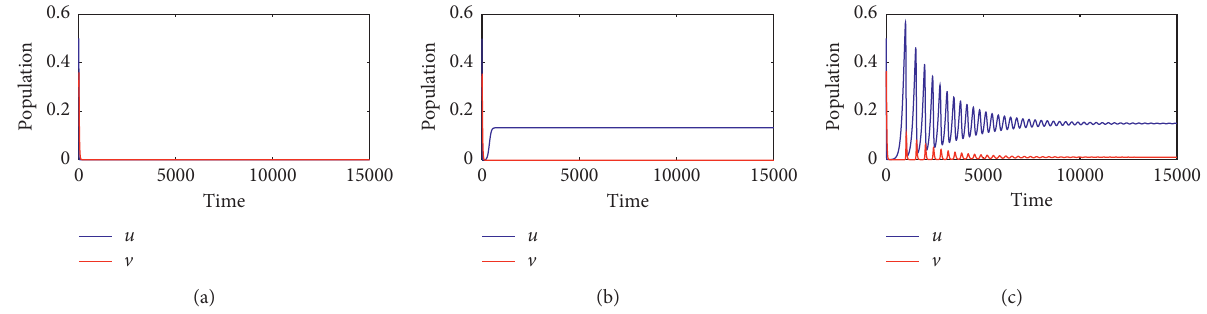
Figure 3: The time series evolution of prey population u ( t ) and predator population v ( t ) for the model system (4) with parameters is defined in numerical section. The subplot (a) shows that trivial singular point E ( 0 . 1333 , 0 ) is locally asymptotically stable, and (c) the coexisting steady state E ∗ ( 0 . 1493 , 0 . 0102 ) is stable point E 1